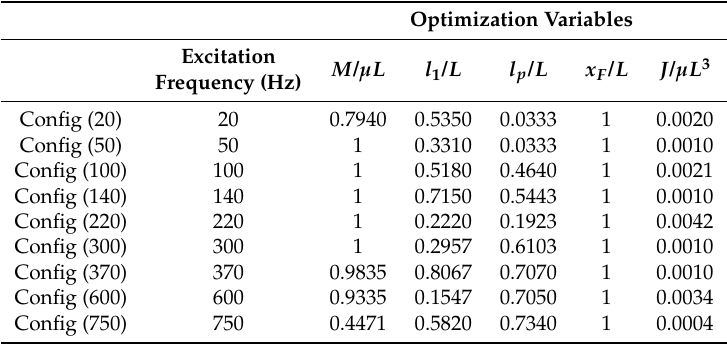
Table 2. Optimization Variables for different excitation frequency.